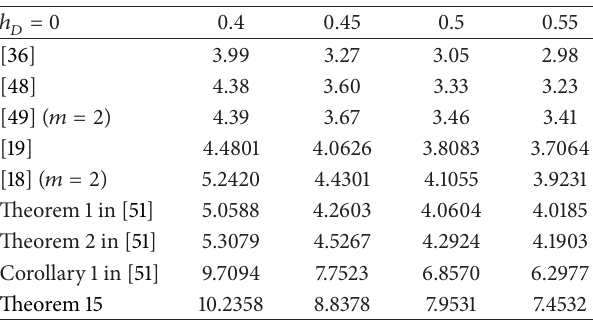
Table 6: Maximum allowable time-delay upper bounds ℎ in Case